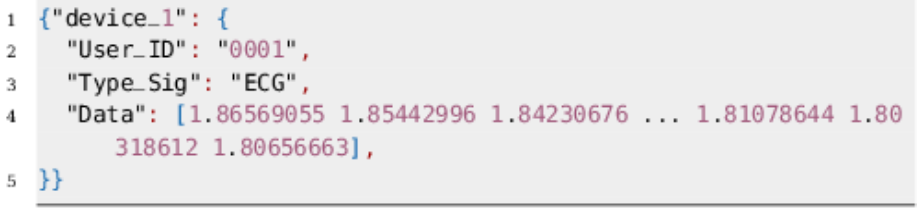
Figure 5. Hardware Deployment.